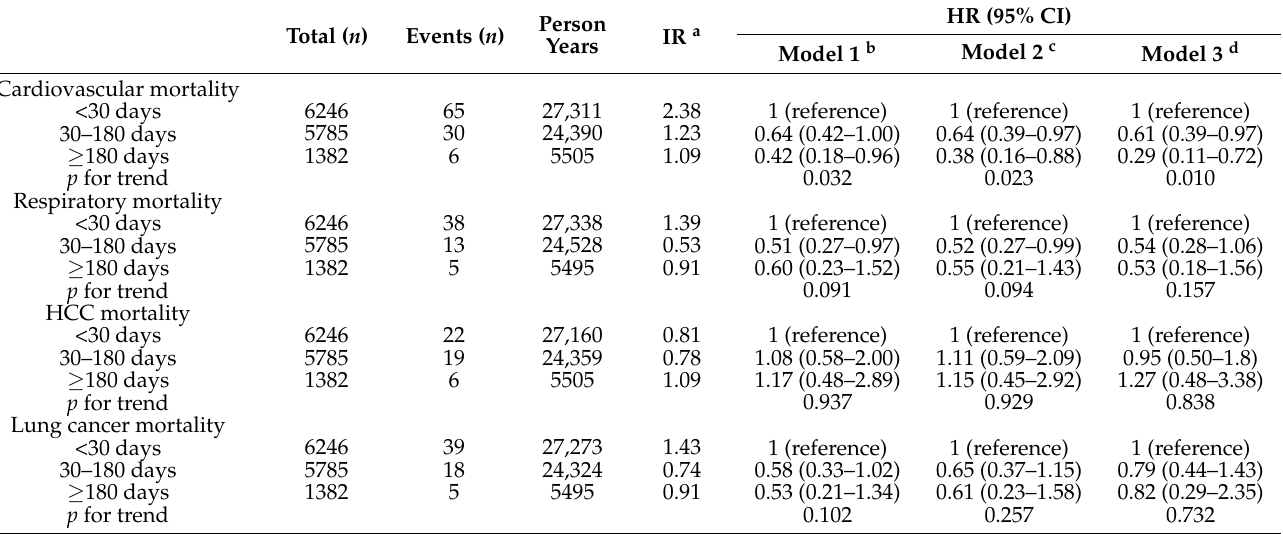
Table A1. HRs (95% CIs) of the risks of cause-specific mortality according to duration of use of carnitine-orotate